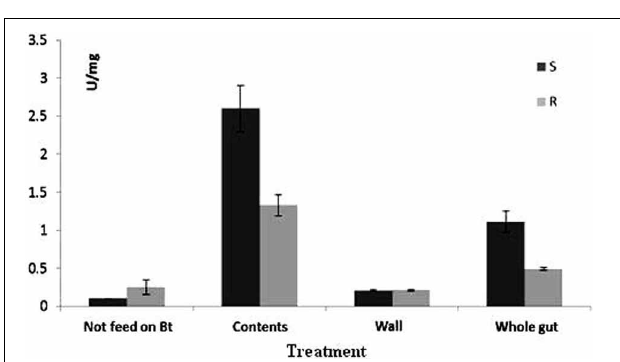
FIGURE 2 | Mean ( ± SE) activity of trypsin-like enzyme for Plutella xylostella larvae of resistant (R) and susceptible (S) populations.